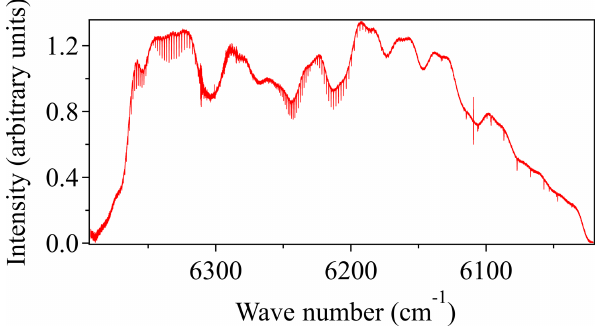
Figure 2. Typical 32s spectrum measured over the 2km reference path. CO 2 bands are observed in the 6350 and 6225cm − 1 regions, while CH 4 and H 2 O are measured between 6150 and 6050cm − 1 . The larger, slowly varying structure is from the comb intensity pro- file. The atmospheric absorption appears as the small and narrow